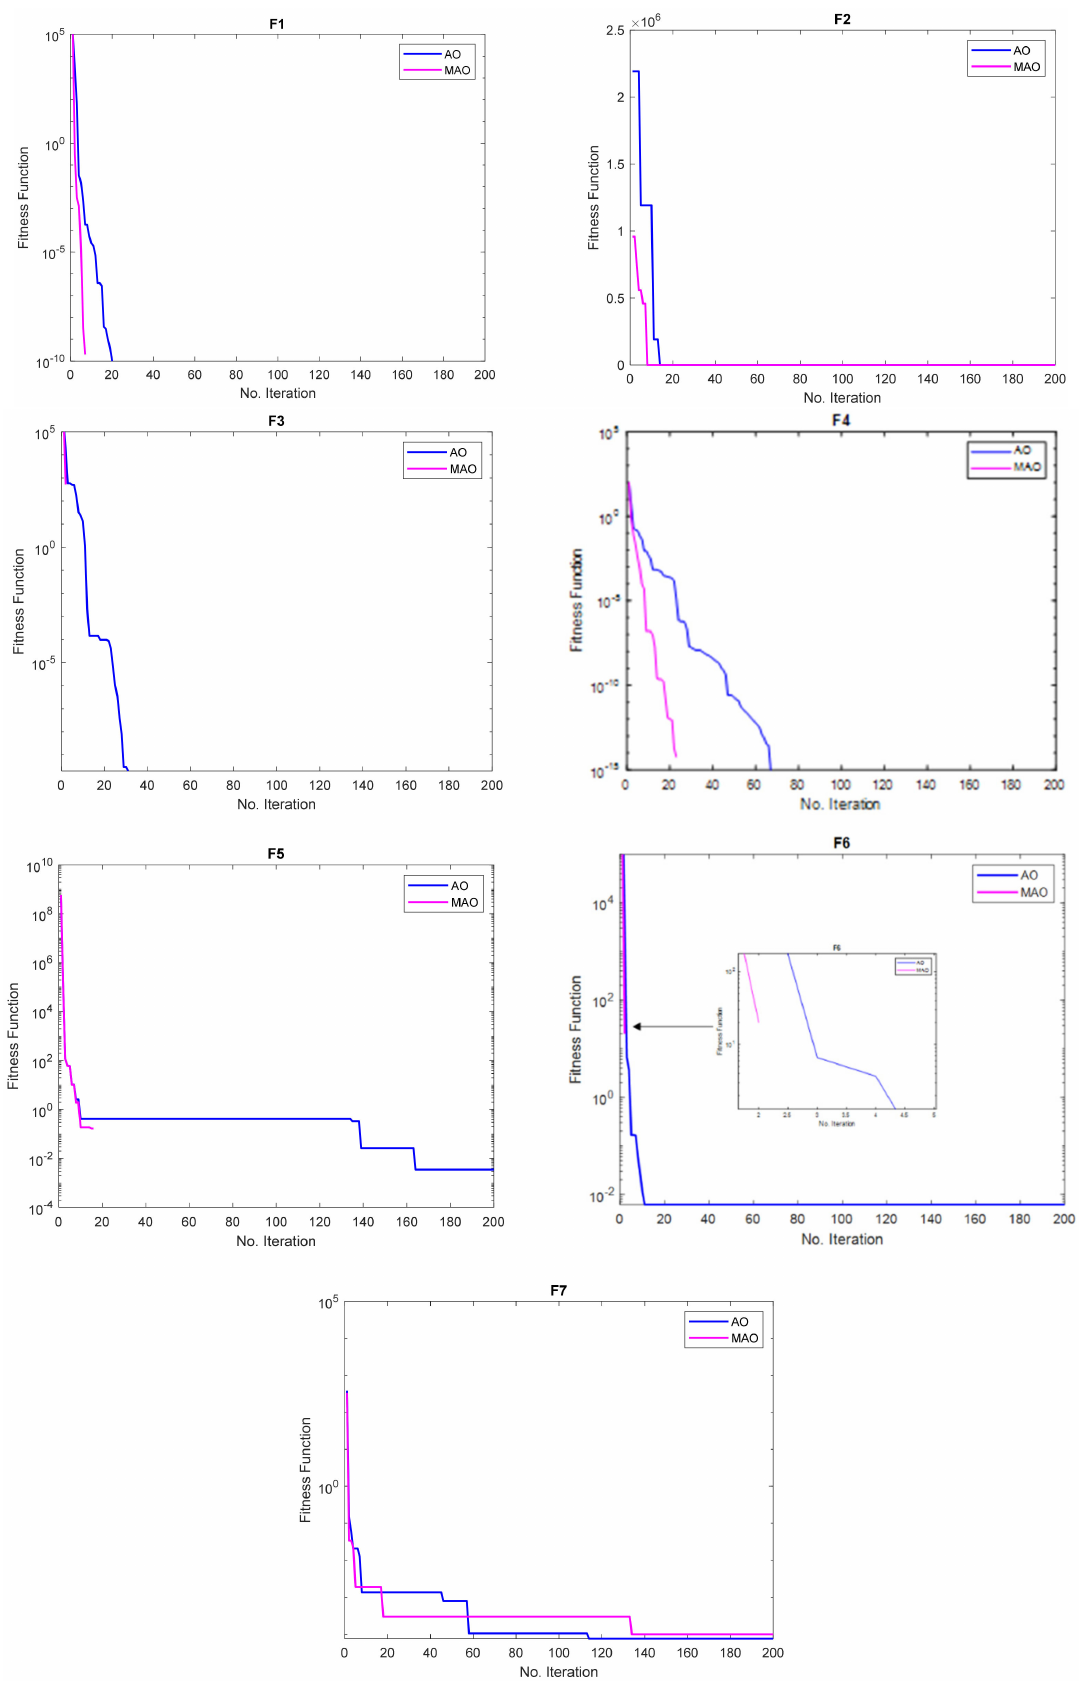
Figure 5. Convergence analysis of unimodal benchmark functions with D =